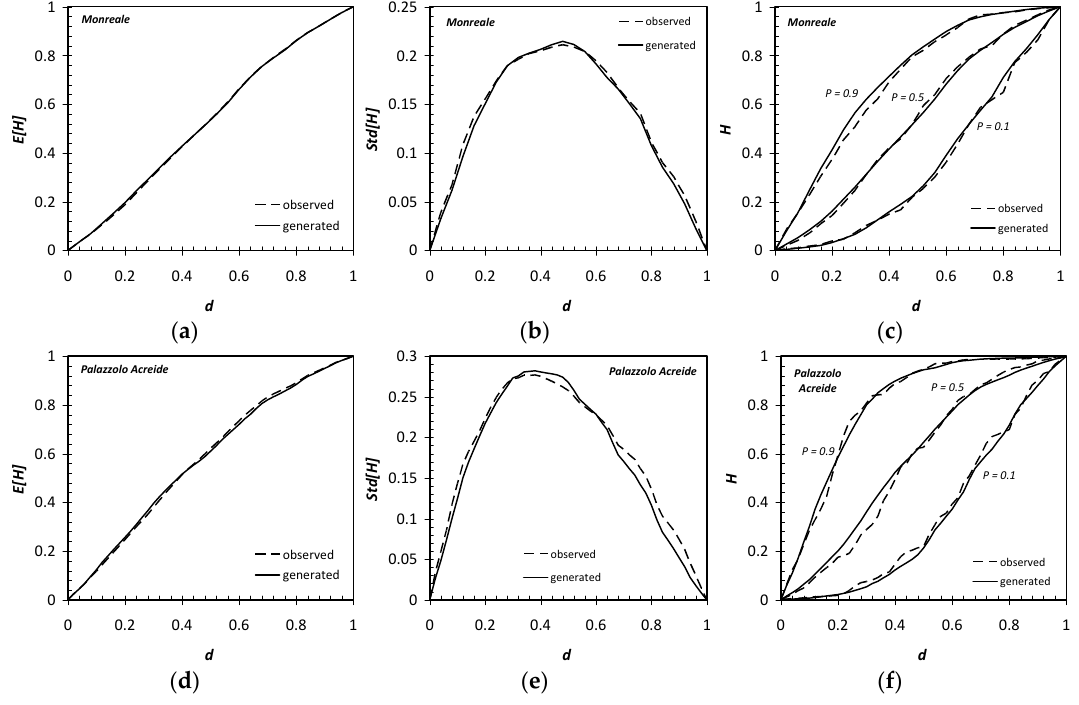
Figure 10. Comparison between observed and generated hyetograph shape: ( a ) mean at the Monreale rain gauge station; ( b ) standard deviation at the Monreale rain gauge station; ( c ) 10th, 50th and 90th at the Monreale rain gauge station; ( d ) mean at the Palazzolo Acreide rain gauge station; ( e ) standard deviation at the Palazzolo Acreide rain gauge station; ( f ) 10th, 50th and 90th at the Palazzolo Acreide rain gauge station.